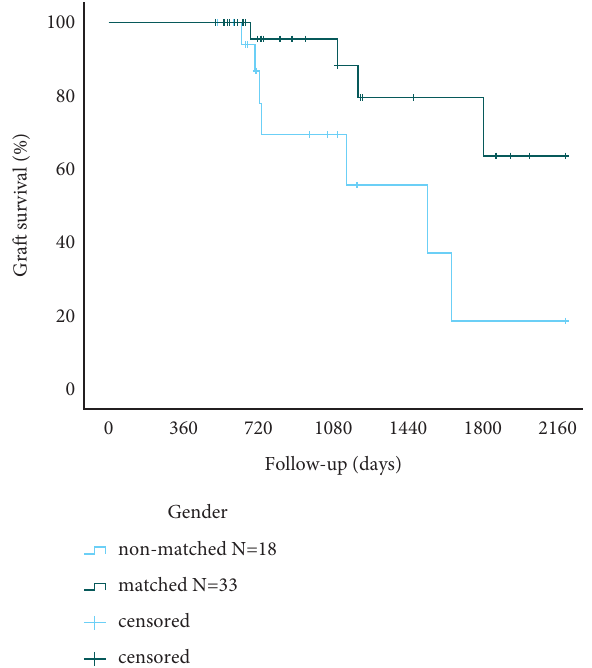
Figure 2: Corneal graft Kaplan–Meier survival curves in gender matched and mismatched high-risk patients ( p � 0 . 022, log-rank